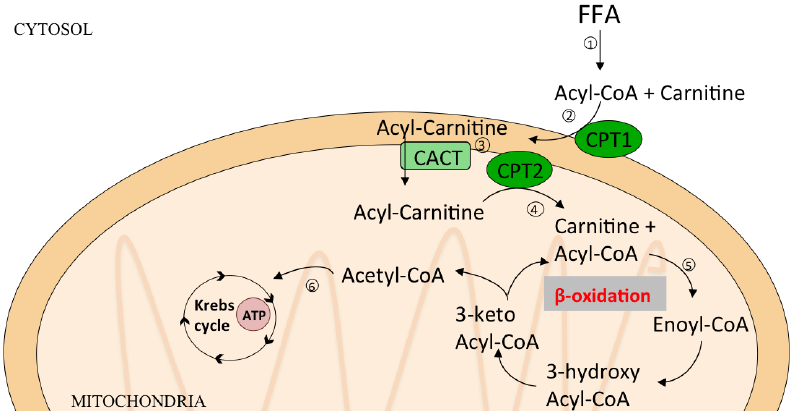
Figure 5. Pathways of β-oxidation. β-oxidation is the catabolic pathway that occurs in mitochondria and produces energy from TG hydrolysis. (1) FFA are transformed to Acyl-CoA in cytosol; (2) protein Carnitine Palmitoyl Transferase-1 (CPT1) catalizes the transfer of the acyl group of a long-chain fatty acyl-CoA to carnitine to form acylcarnitines (mainly Palmitoylcarnitine); (3) Carnitine Acyltranferase (CACT) transfers acylcarnitine across outer mitochondrial membrane; (4) Carnitine Palmitoyl Transferase-2 (CPT2) reconverts acylcarnitine in acylCoA and carnitine; (5) Acyl-CoA enters in β-oxidation cycle and is degraded in several Acetyl-CoA molecules; (6) Acetyl-CoA enters in Krebs cycle to produce energy as Adenosine Triphosphate (ATP).